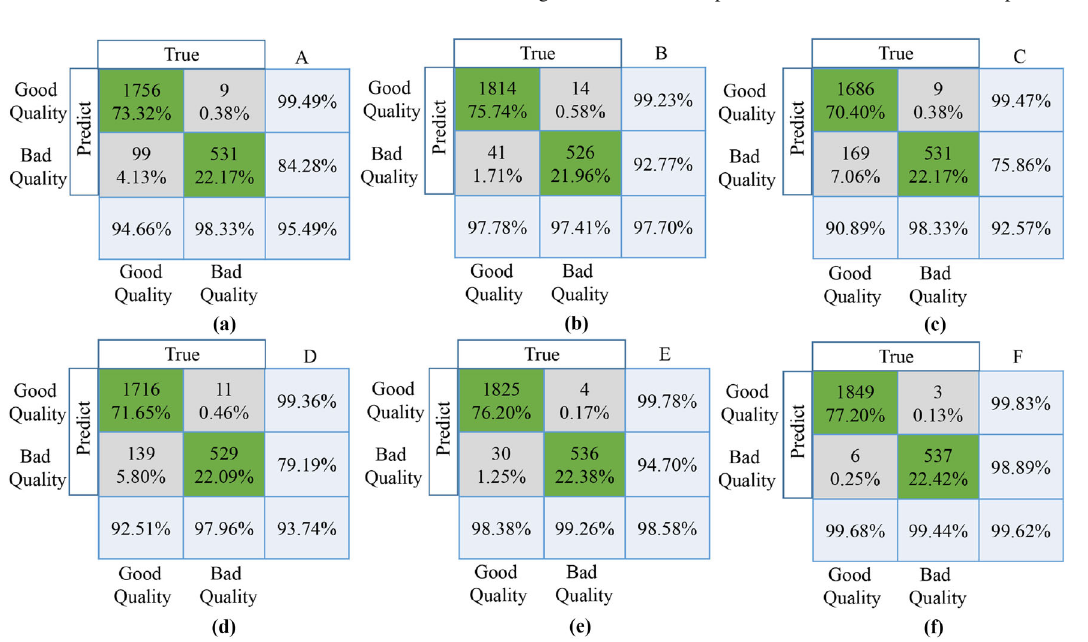
Table 9 Results of ablation studies performed on DI-Transformer with five-fold cross-validation